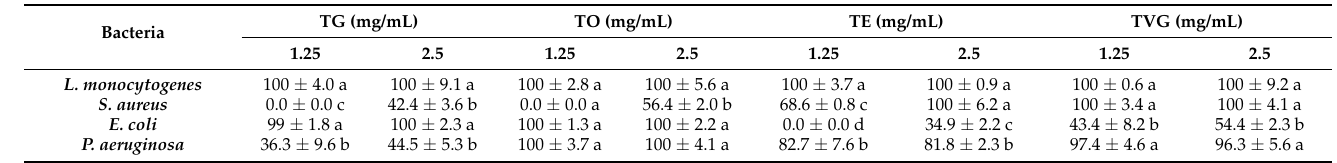
Table 2. Percentage of inhibition of Gram-positive and Gram-negative bacteria by tannin samples at concentrations of 1.25 and 2.5